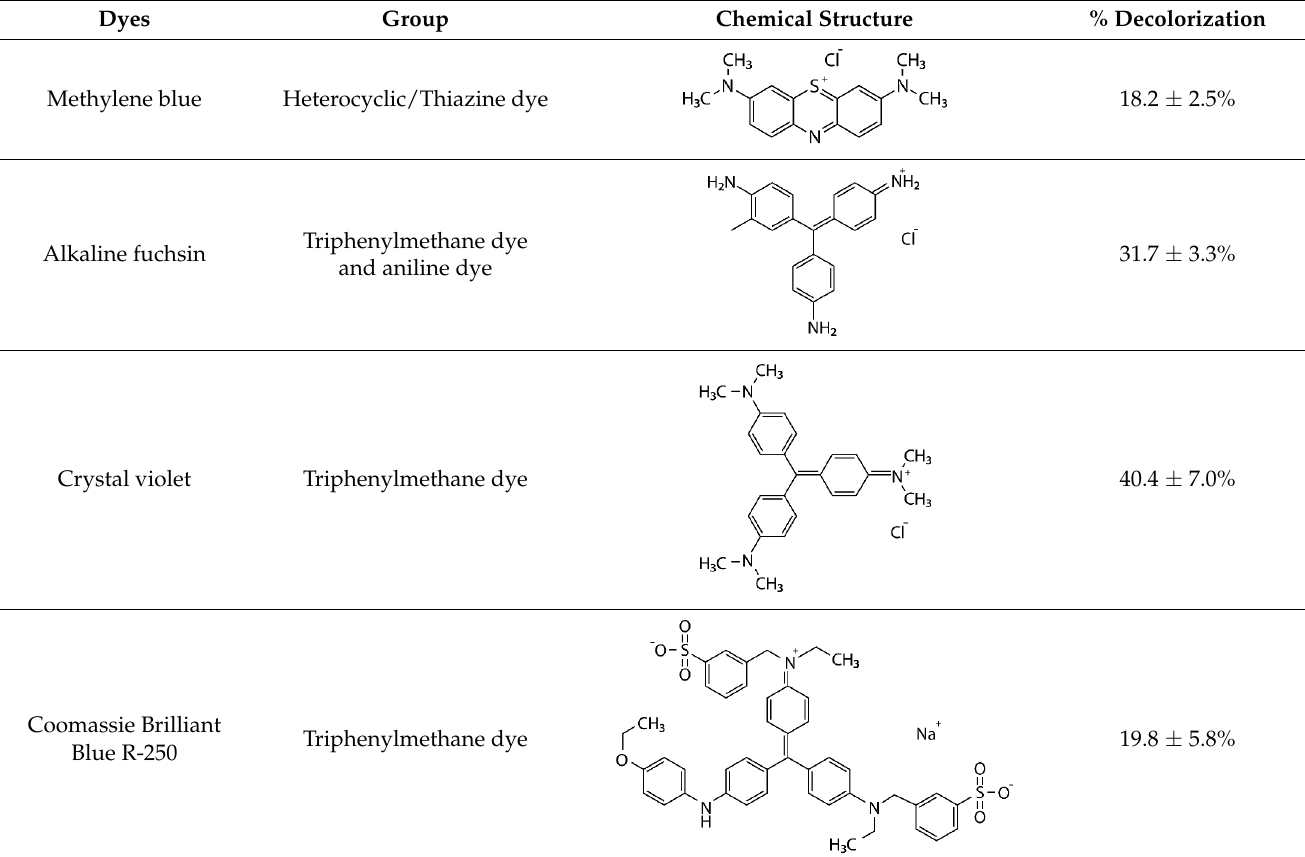
Table 3. Decolorization of the synthetic dyes using laccase G3.